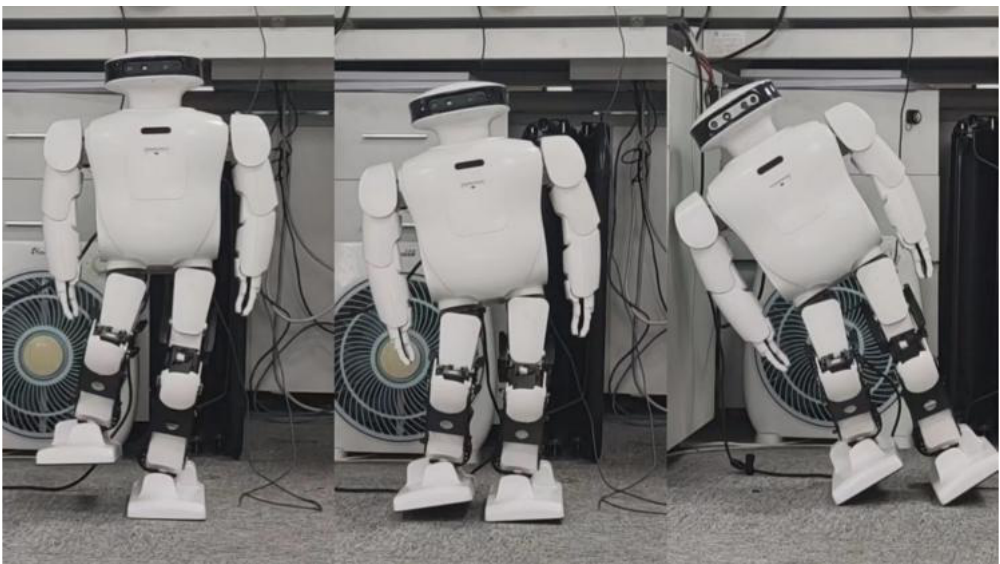
Figure 16. When Roban’s COM moves 4.3 cm, the robot fell while squatting.